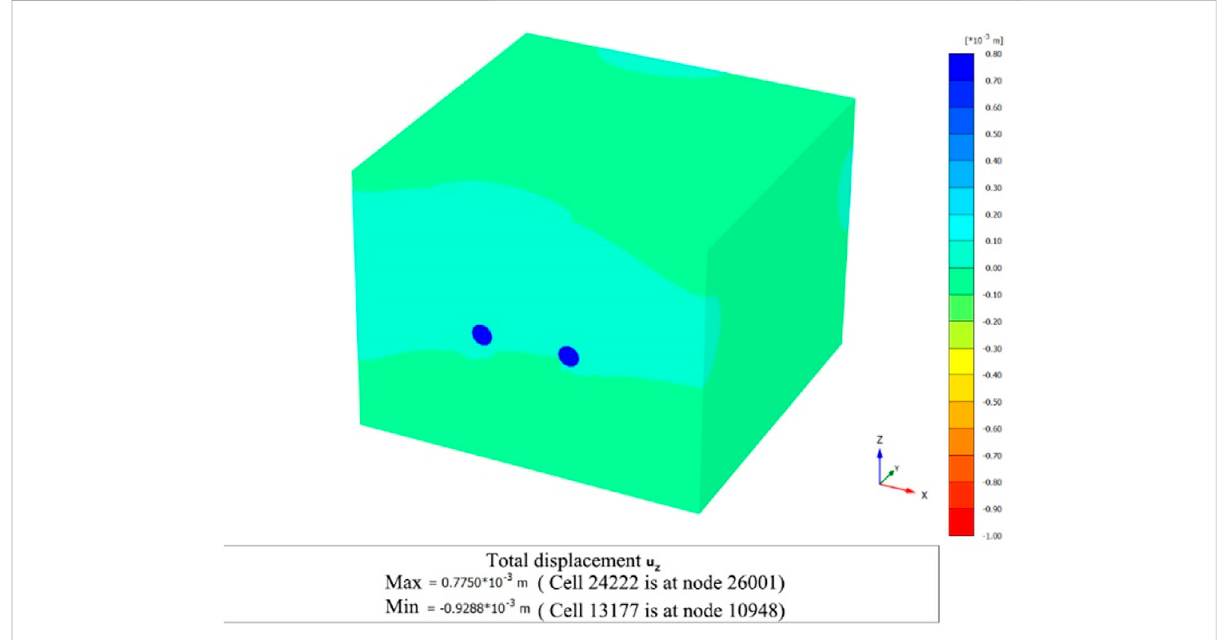
FIGURE 15 Vertical displacement nephogram of the soil in connecting aisle No.